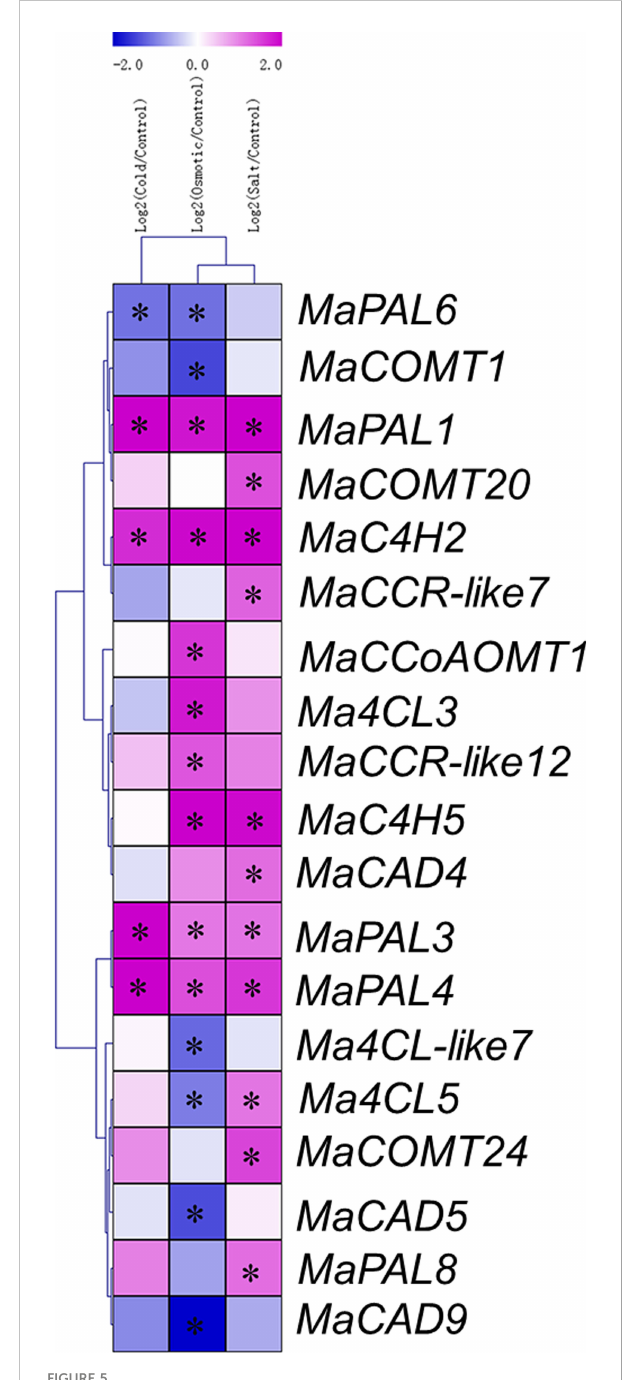
FIGURE 5 Expression patterns of lignin synthesis genes in response to cold, osmotic, and salt treatments in banana. The Log2-based fold change was used to create the heatmap. Differences in gene expression changes were shown in color as the scale. * Signi fi cant difference at P <